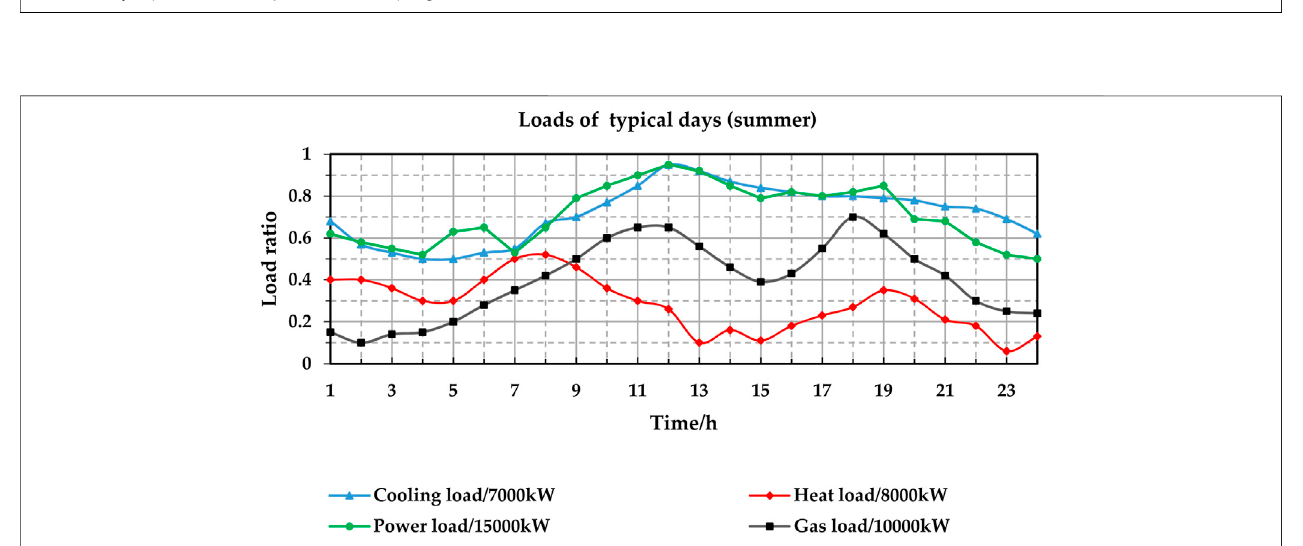
FIGURE 6 | Representative daily load curve in summer.